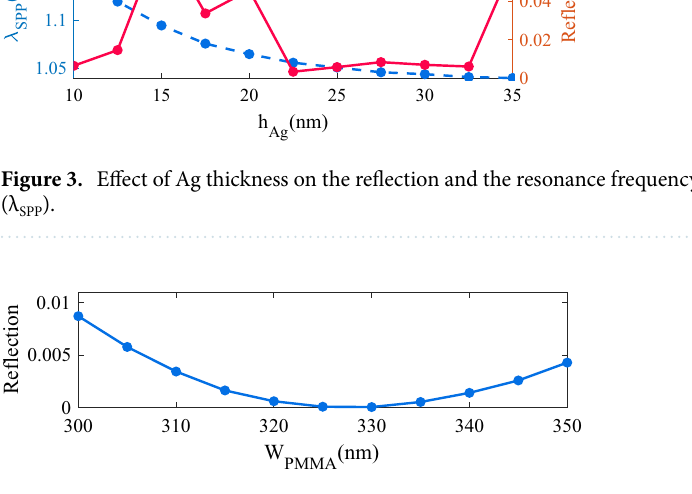
Figure 4. Effect of W PMMA on the reflection for Ag = 20 nm, h SiO 2 = 1500 nm, Λ PMMA = 700 nm, and h PMMA = 250 nm (calculated at λ = 1063